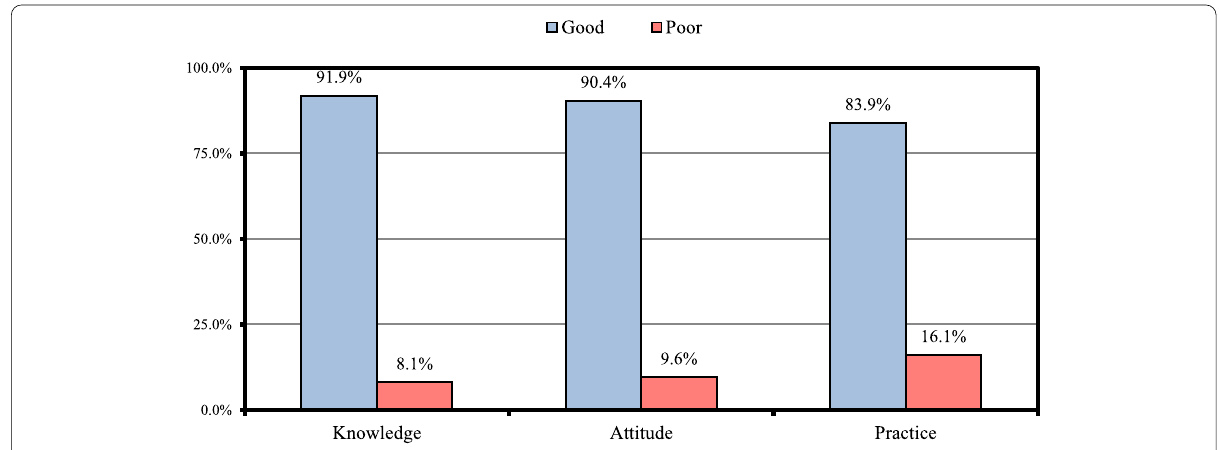
Fig. 1 Level of knowledge, attitude, and practice of ear care among the study